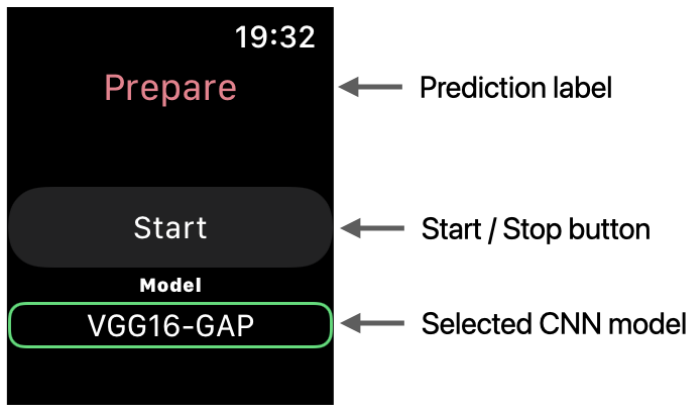
Figure 9. watchOS app used in the